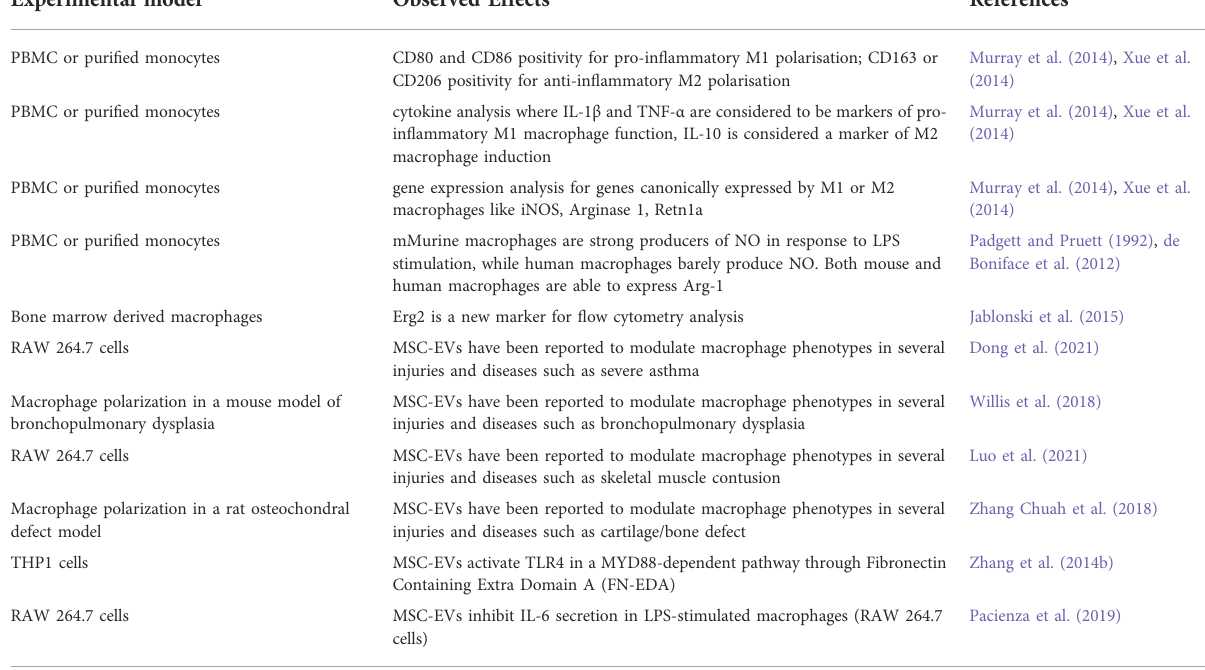
TABLE 3 Macrophage polarization